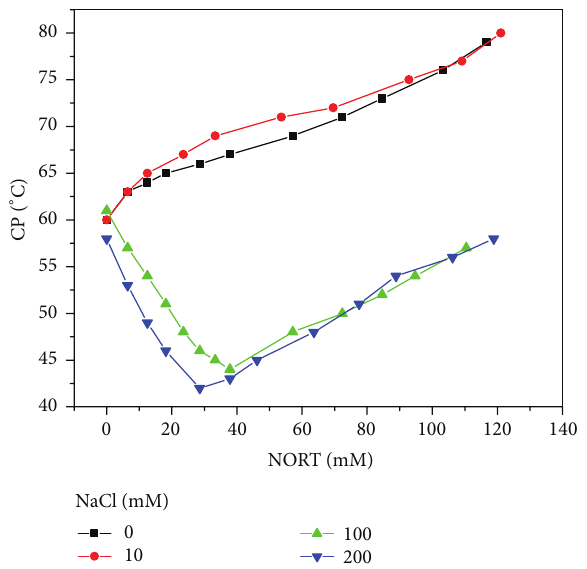
Figure 3: Effect of various concentrations of NaCl on the CP of the IBF-HPMC